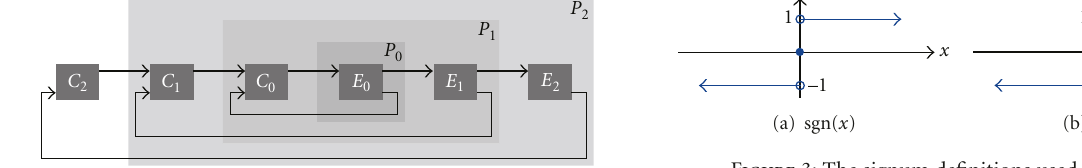
Figure 1: Nesting of controllers coupled to the environment; controller C i regulates its sensory perception of the environment, E i . The derivation of C i considers a plant model, P i , of the world “downstream” from it according to the recursion P 0 : = E 0 and P i : = C i − 1 P i − 1 E i .